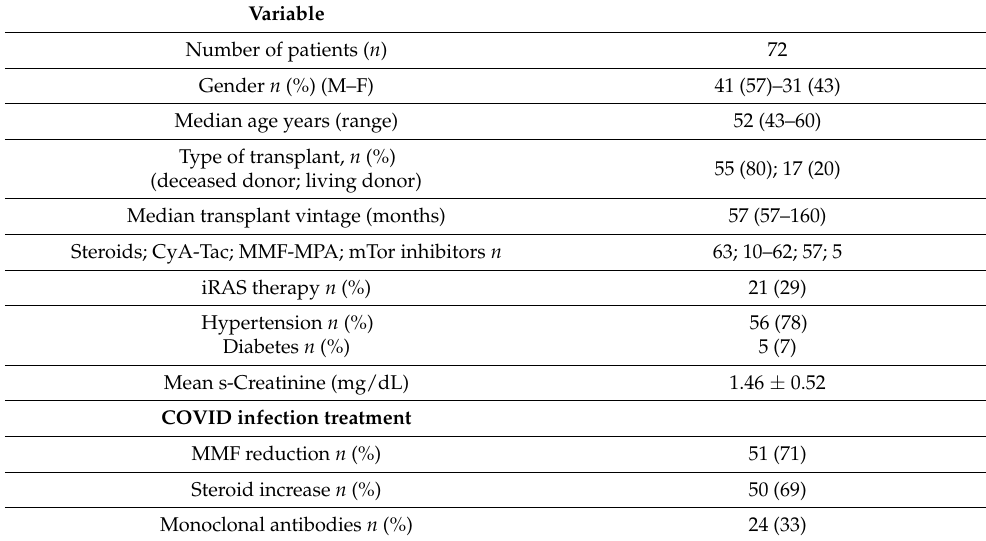
Table 1. Patients’ characteristics and treatment of COVID-19 infection.